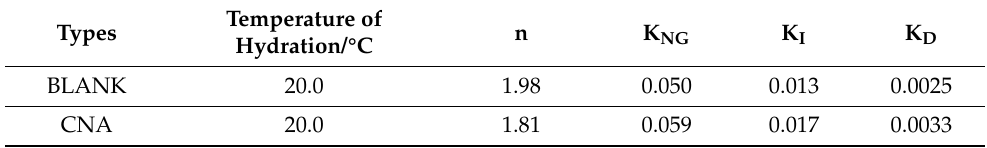
Figure 4. Fitting curves of kinetics parameters in NG stage ( a ), I stage ( b ) and D stage ( c ) of blank sample; Fitting curves of kinetics parameters in NG stage ( d ), I stage ( e ) and D stage ( f ) of cement mixture with CNA. Table 2. Dynamic parameter solution results.